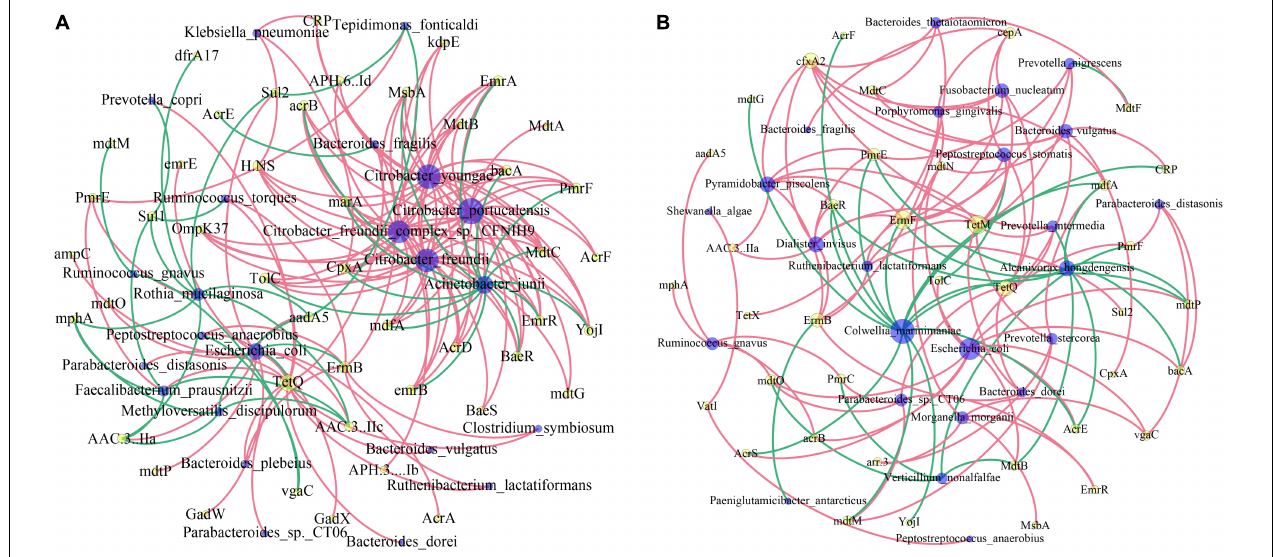
FIGURE 6 | Network analysis of co-occurrence patterns among antibiotic resistance gene (ARG) subtypes and microbial taxa in IVF (A) and tissue (B) . The nodes are colored according to ARG types and species. A connection represents a strong (Spearman’s correlation coefficient r > 0.4) and significant ( p < 0.05) correlation. The size of each node is proportional to the number of